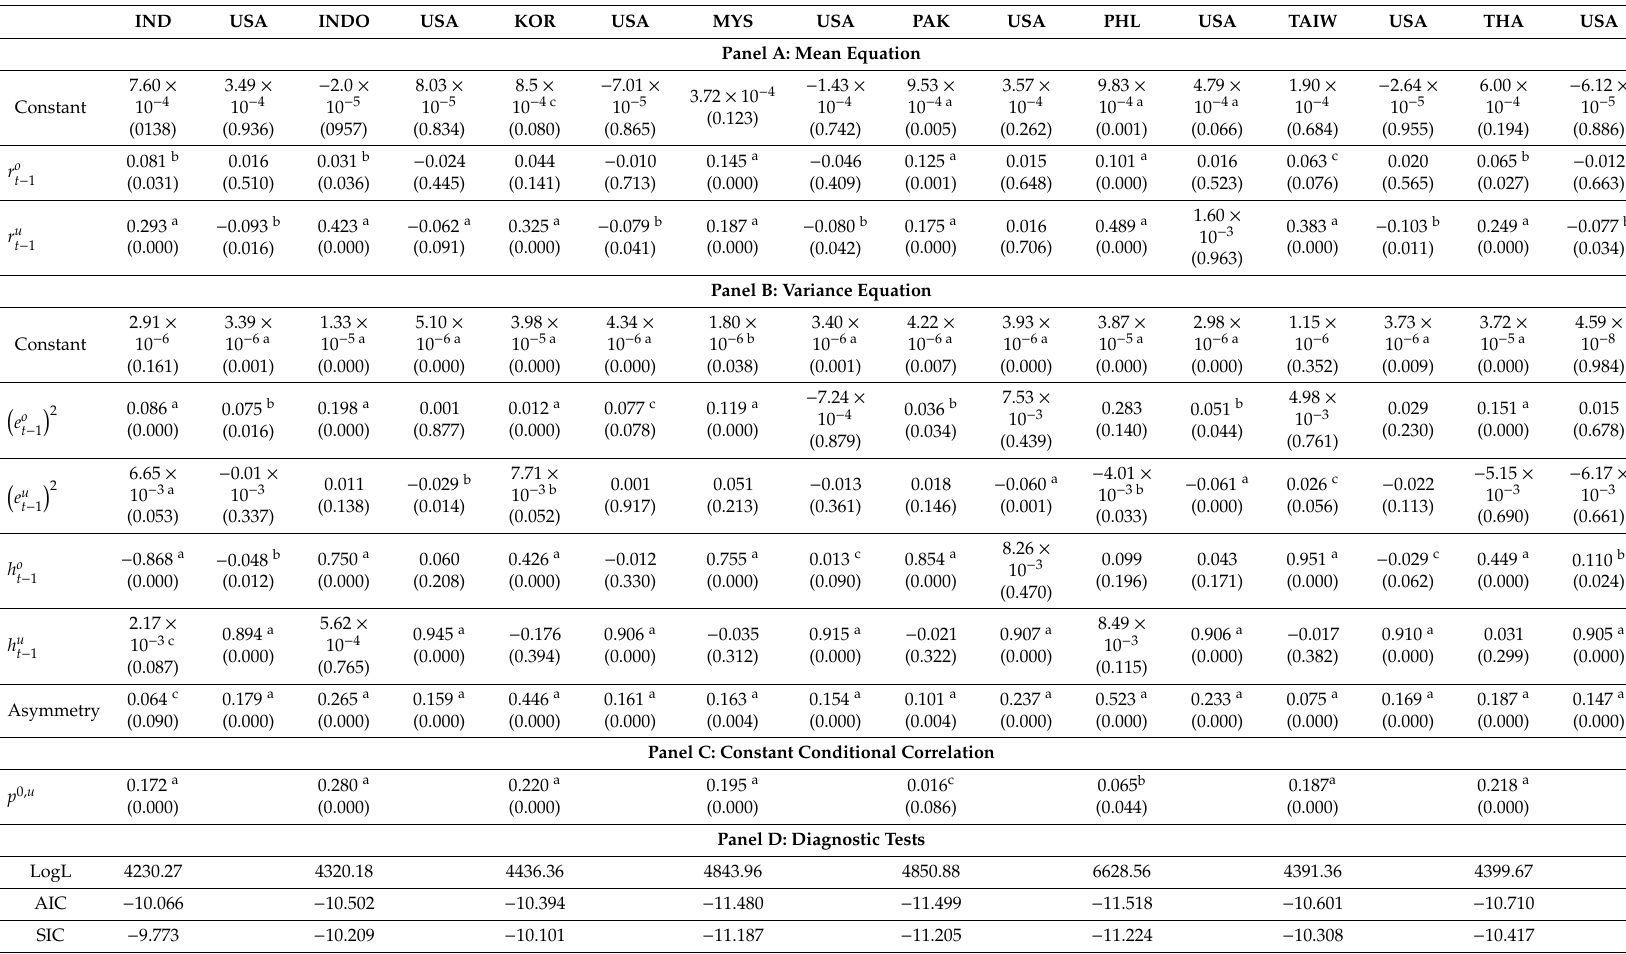
Table 4. Estimates of bivariate VAR − AGARCH for the American and Asian stock markets during the US Financial